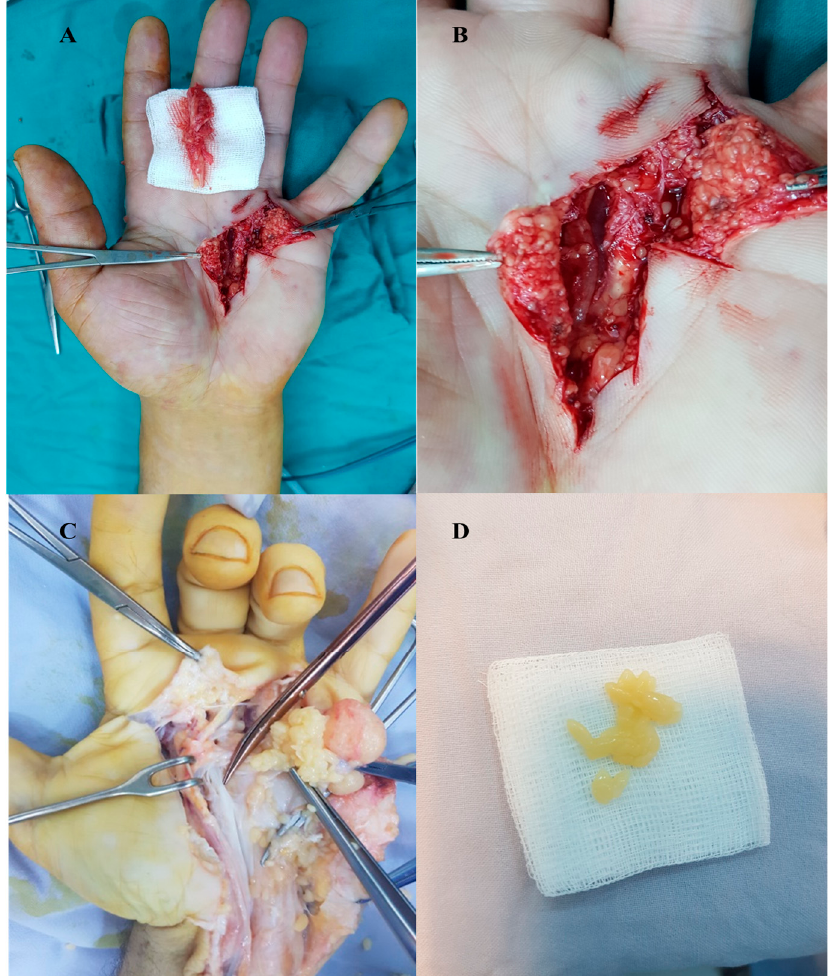
Figure 14. Tenosynovitis with “rice bodies” ( A , B ) localization on the ulnar aspect of the palm ( B ) detail), ( C ) mediopalmar localization, ( D ) “rice bodies” .